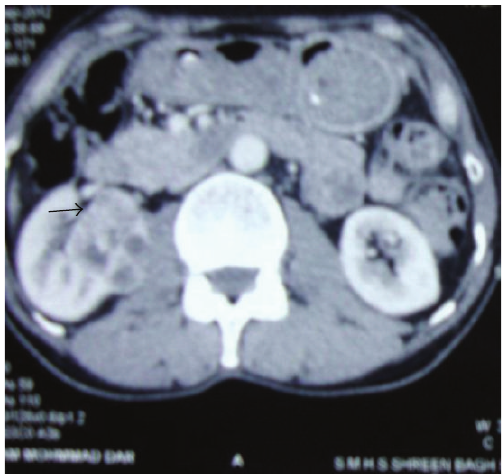
Figure 4: CECT abdomen, axial cuts showing well circumscribed mass arising from right kidney with stranding of perinephric